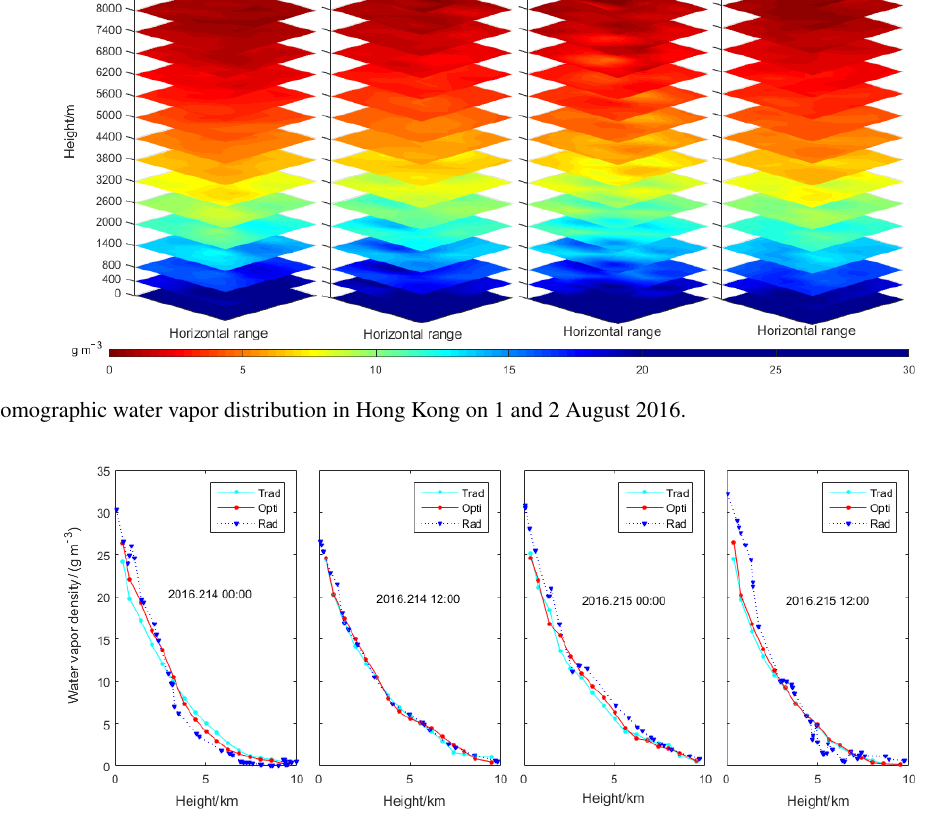
Figure 5. Water vapor densities obtained from tomography-derived and radiosonde-derived data. Rad is the water vapor density derived using radiosonde products, Trad is the water vapor density derived using the traditional tomography method, and Opti is the water vapor density derived using the optimized method.